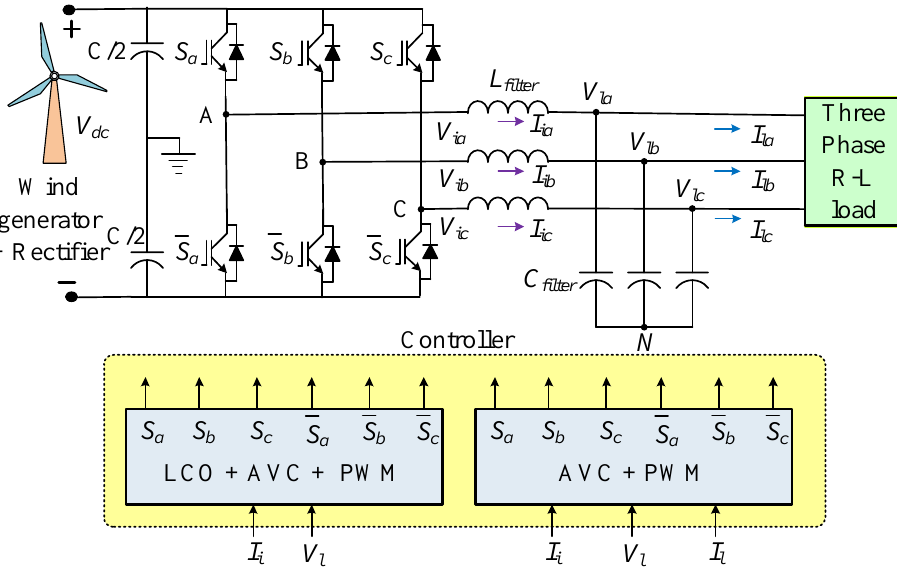
Figure 1. Schematic circuit diagram of the wind energy conversion system.